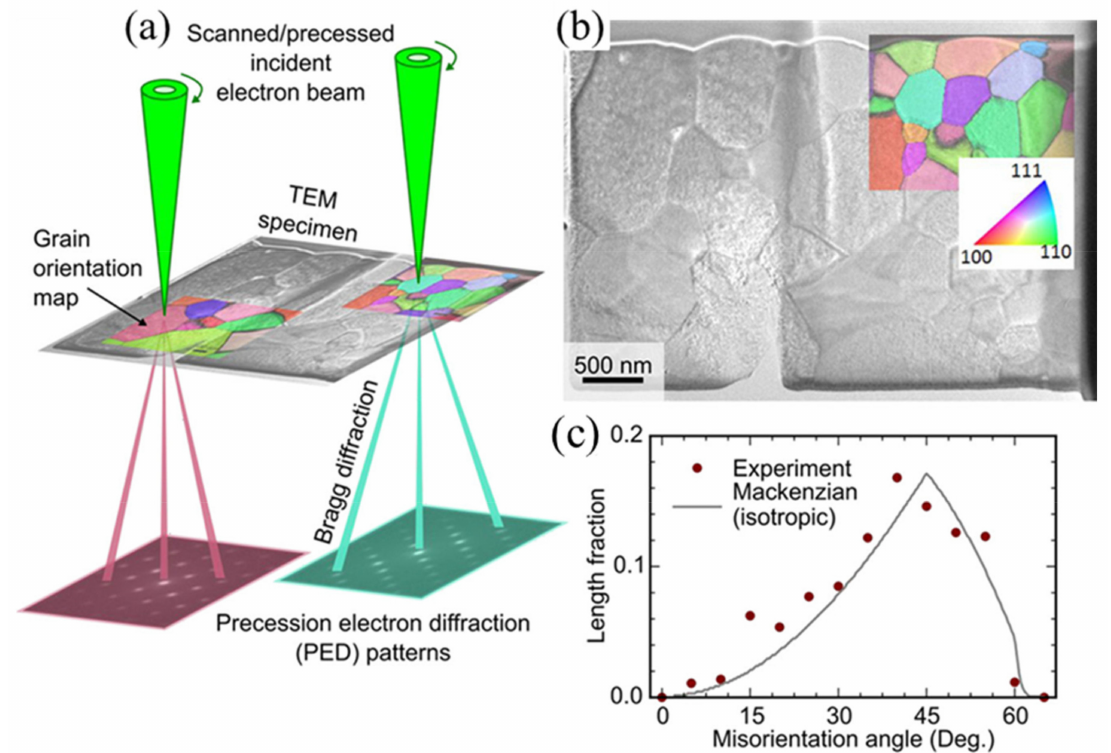
Figure 27. ( a ) Schematics representation of PEND in a TEM that enables grain and GB orientation mapping via precession of the electron beam. ( b ) Bright-field TEM image of Pr and Gd-co doped ceria (PGCO) specimen with overlaid inverse pole figures, grain orientation is indicated via color code corresponding to inset stereographic triangle. ( c ) Misorientation angle distribution and Mackenzian distribution [7]. Reprinted from Copyright © 2020 American Chemical